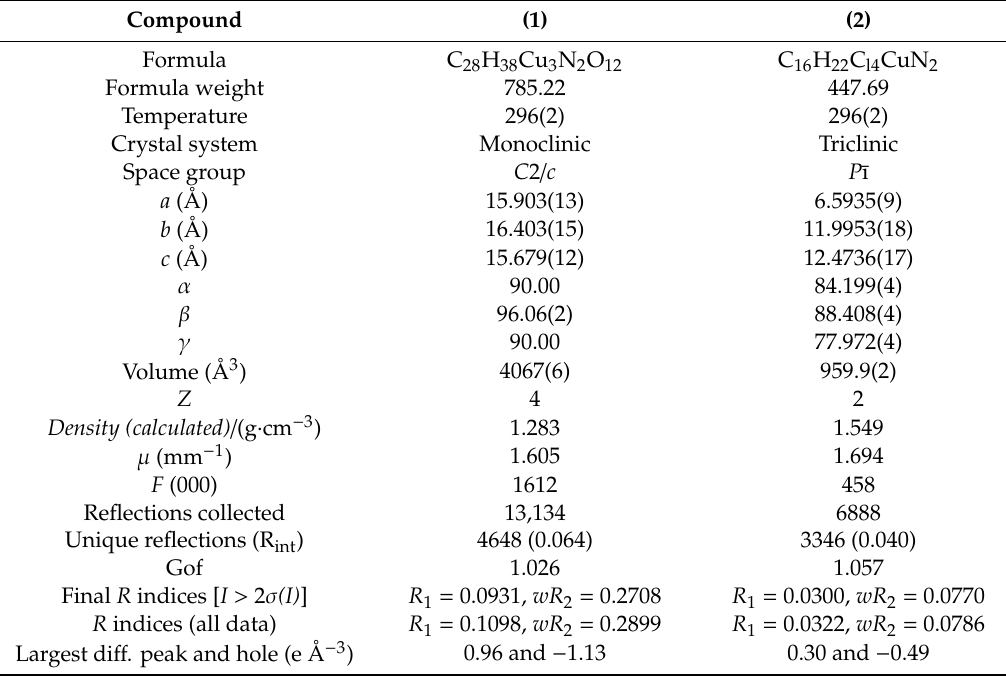
Table 1. Crystallographic data for compounds ( 1 ) and ( 2